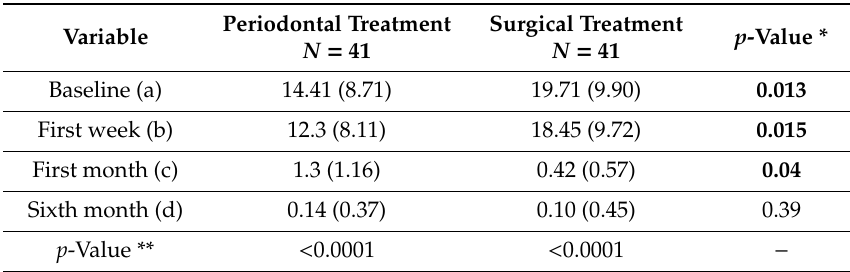
Table 2. Oral Health Impact Profile (OHIP)-14 scores in the periodontal and surgical groups at baseline, and postoperatively at the first week, the first month, and at 6